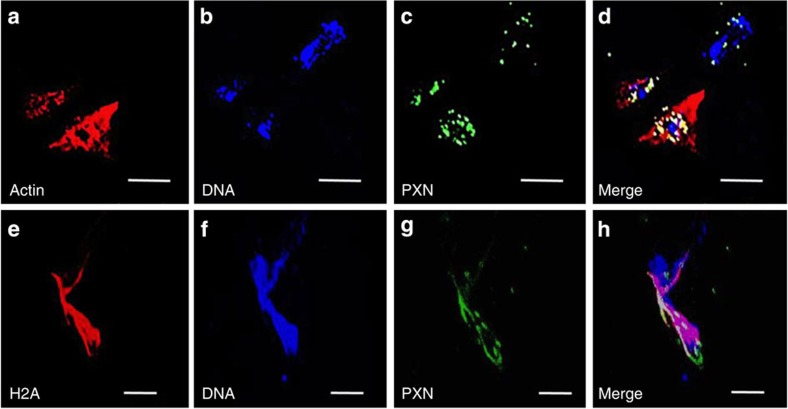
Immunocytochemical analysis of chromatin released from HCs of C. maenas in vitro.(a–d) Localization of actin, DNA or PXN in an ETotic haemocyte (top right) and two non-ETotic haemocytes (bottom left), 24 h incubation with 0.1 μM PMA. (a) Actin shown by rhodamine phalloidin. (b) Visualization of DNA by Draq 5. (c) Localization of PXN, by anti-myeloperoxidase (MPO) antibody. (d) Merge of a–c. All scale bars, 25 μm. (e–h) Localization of histone H2A, DNA or PXN in a different ETotic cell. (e) Localization of H2A. (f) Visualization of DNA by Draq 5. (g) Localization of PXN, by anti-MPO antibody. (h) Merge of e–g. Note H2A co-localizes with extracellular DNA and PXN. All scale bars, 20 μm.